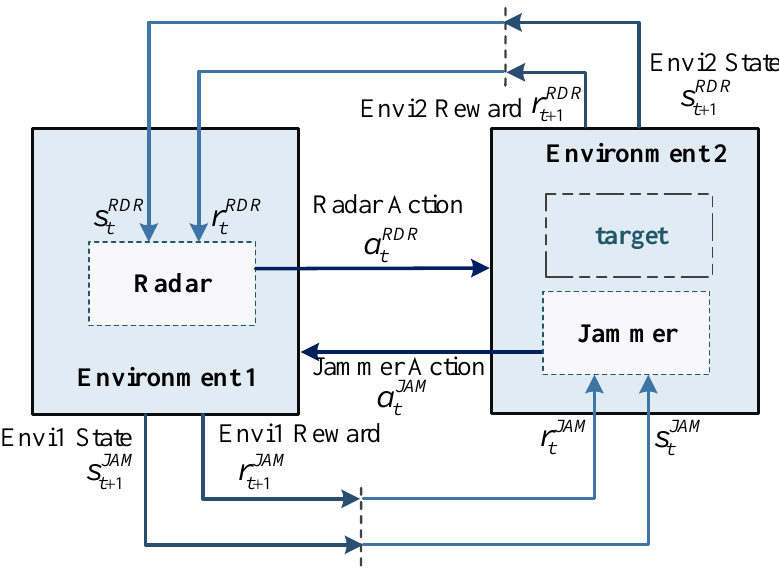
Figure 6. The environment model of radar-jammer system proposed in this paper. The parameter definitions of the radar side and the jammer are shown in Table 2. For the radar side, the environment of the jammer and the target is regarded as Envi2. The radar sends a signal a RDR to Envi2, from which a target state s RDR with t t